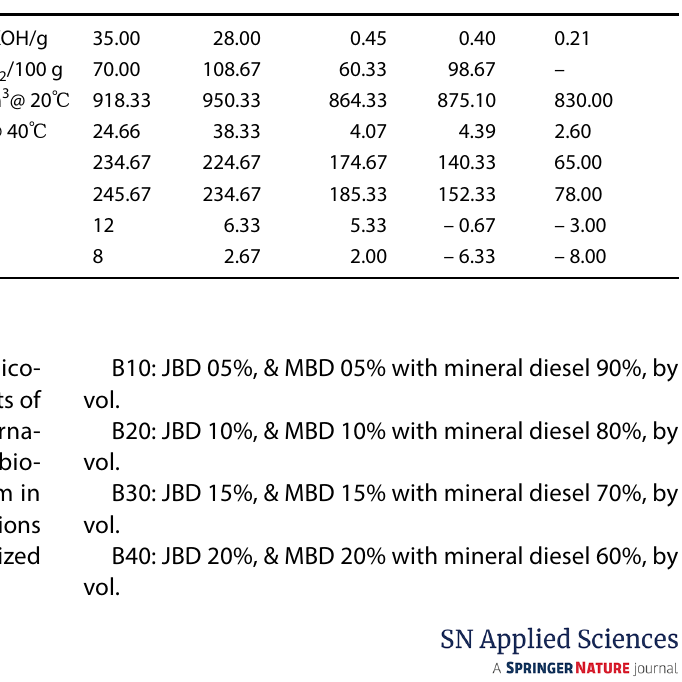
Table 2 Comparison of physicochemical properties of biodiesels [47]